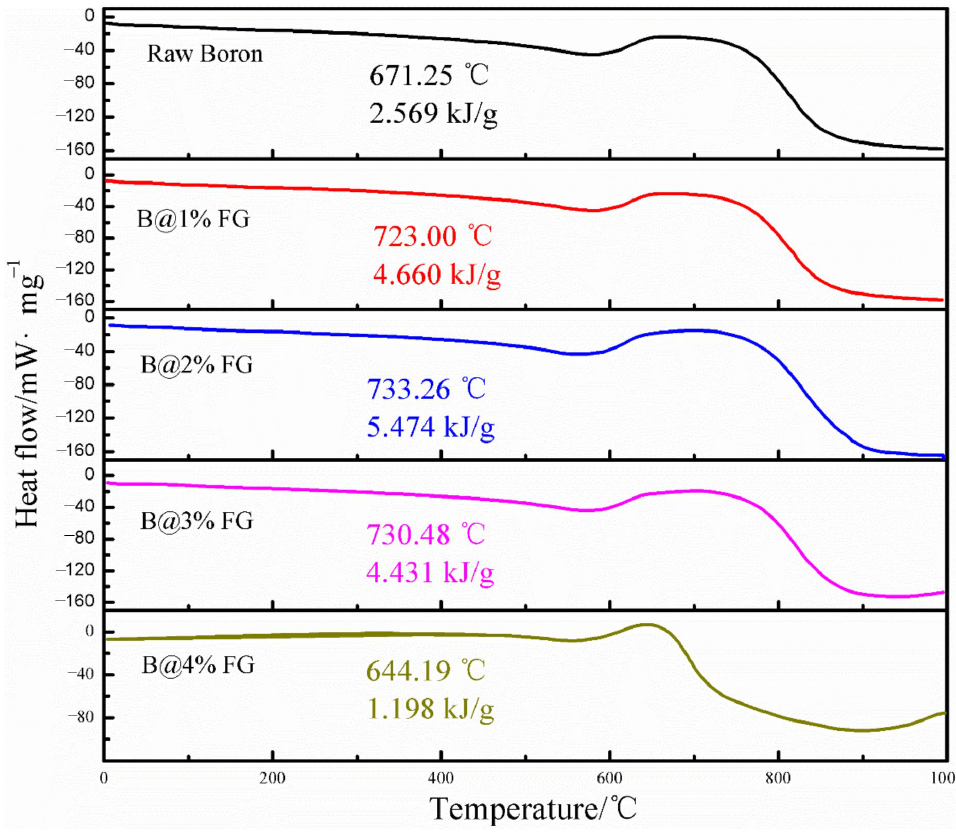
Figure 12. DSC curves of raw boron and B@FG/GF [95].